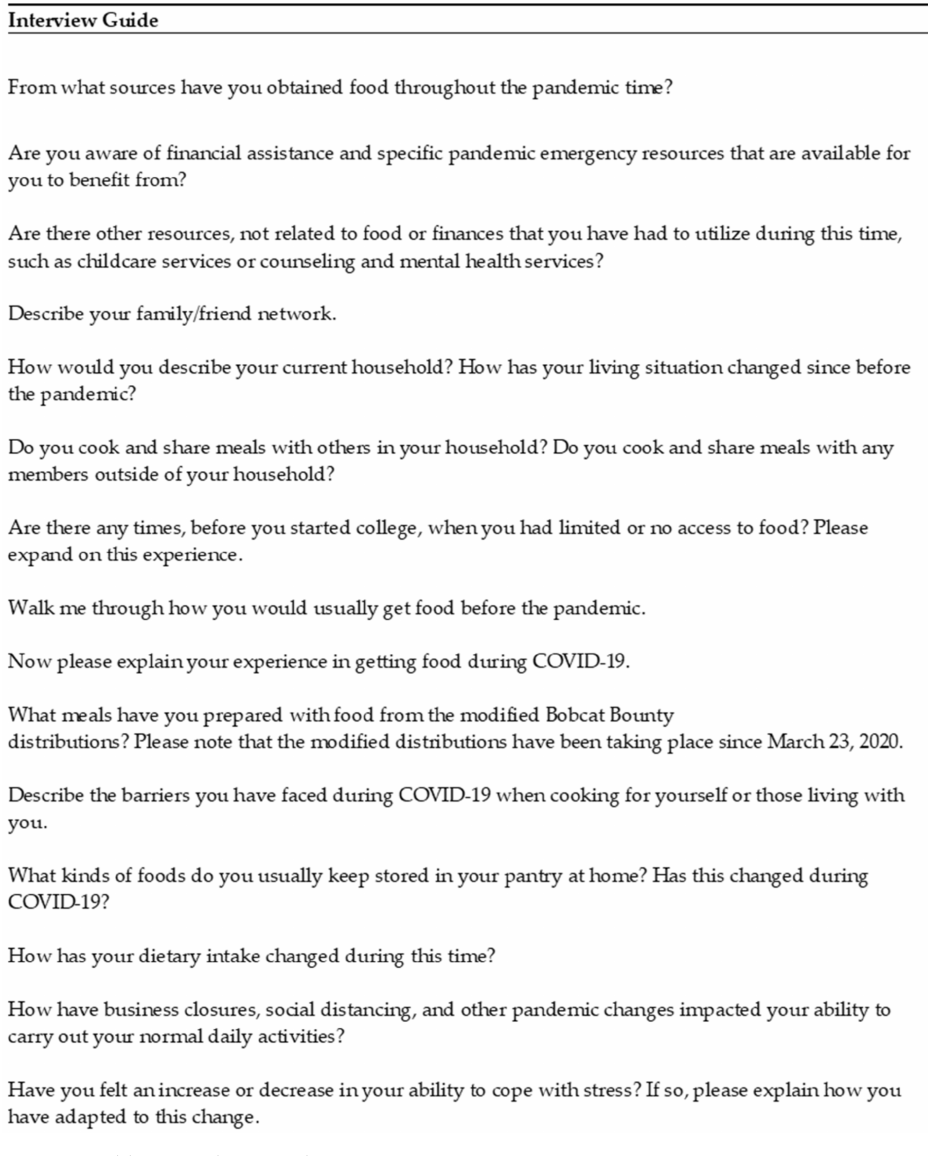
Figure 2. Abbreviated In-Depth